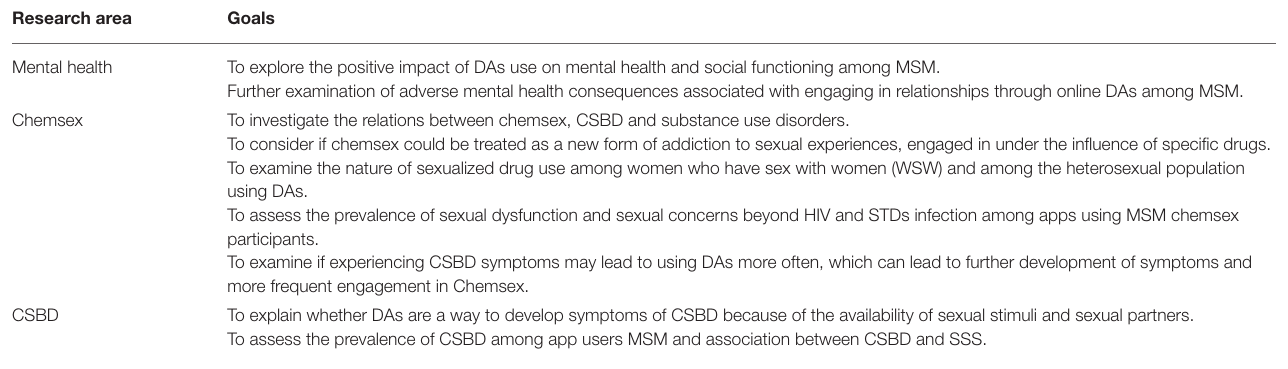
TABLE 1 | Recommendations for future studies on mental and sexual health among DAs users. Research